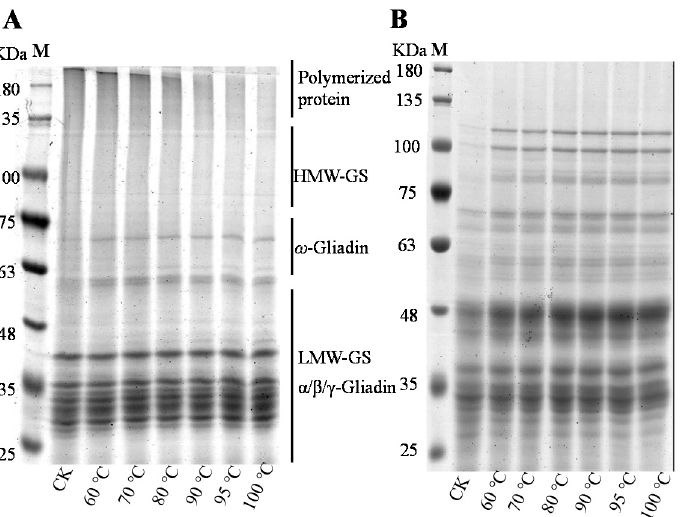
Figure 1. Non-reduced ( A ) and reduced ( B ) SDS-PAGE profiles of protein with different tempera- ture treatment. CK, control; HMW-GS, high-molecular-weight glutenin subunit; LMW-GS, low-mo- lecular-weight glutenin subunit.